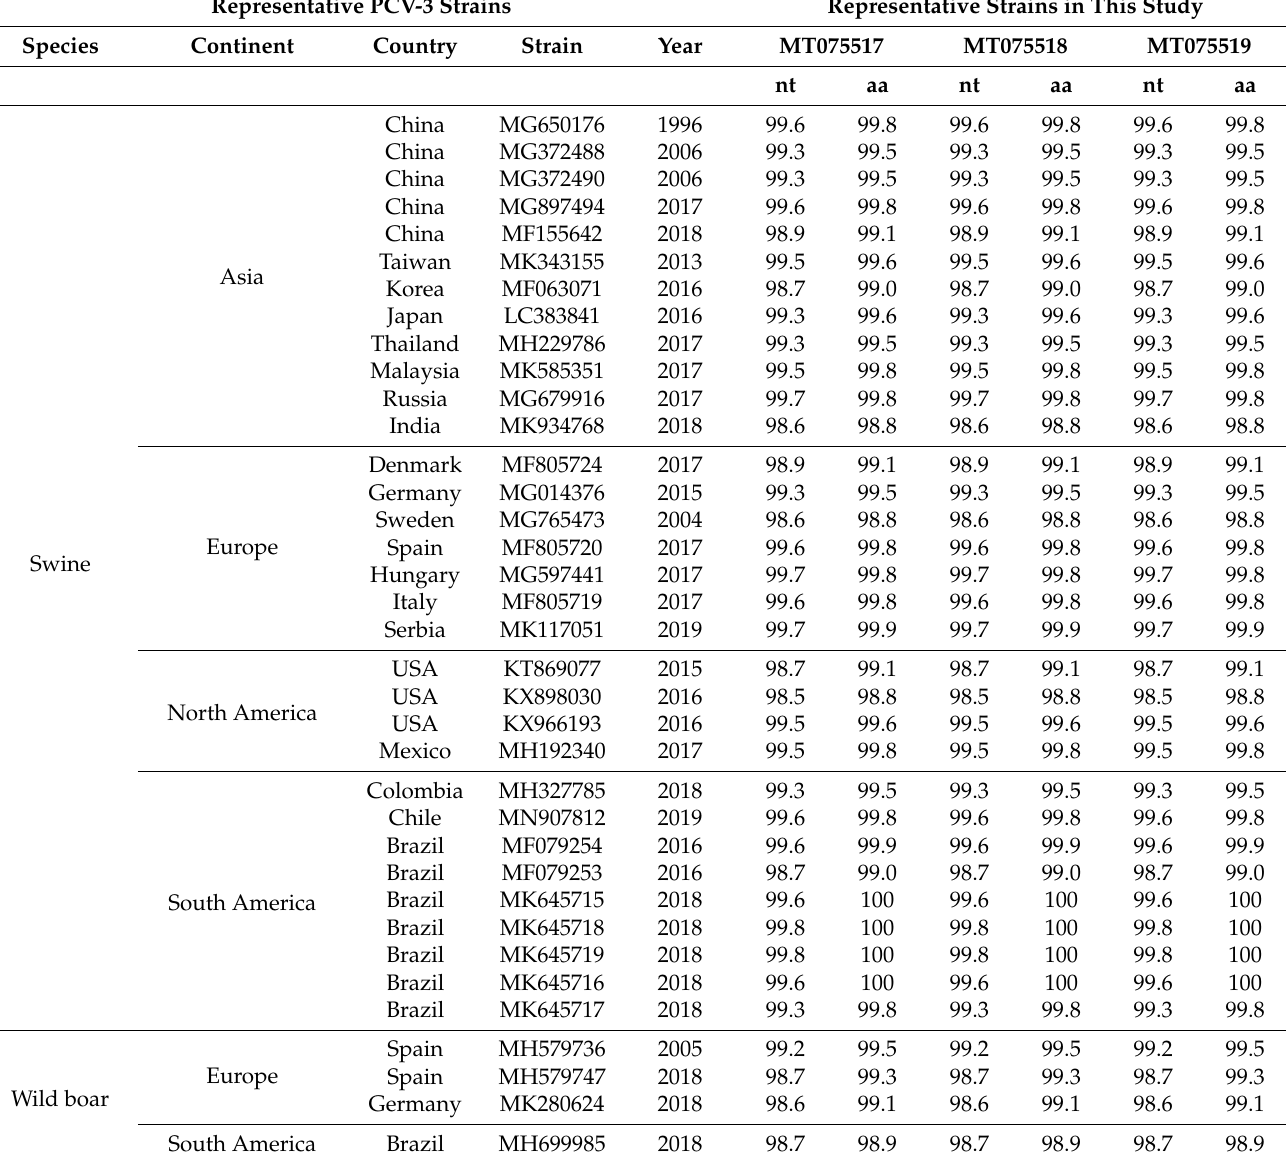
Table 1. Similarities of nucleotides (nt) and amino acids (aa) of the complete genome of porcine circovirus 3 (PCV-3) sequences reported in this study and representative strains from other countries. The complete PCV-3 sequences were analyzed using BioEdit version 7.2.6.1